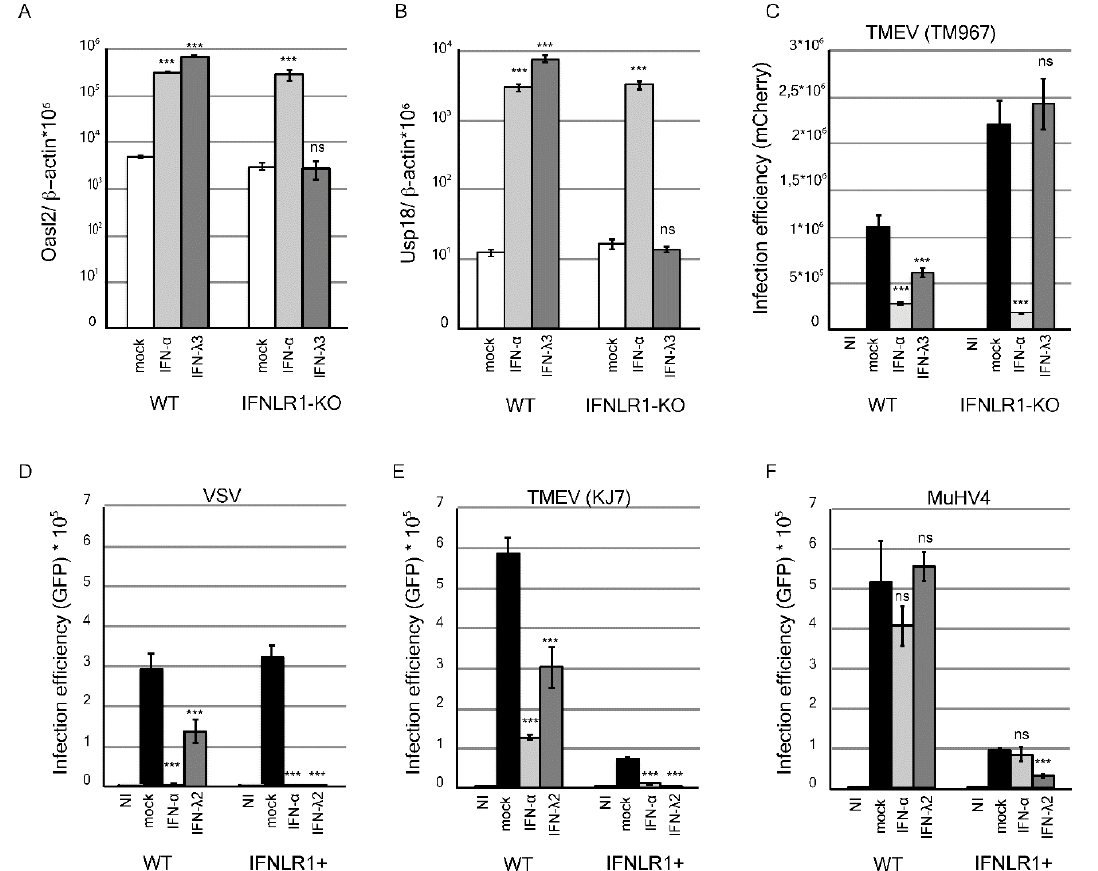
Figure 1. Interferon-stimulated gene (ISG) expression and antiviral activity in response to IFN- λ treatment in WT and IFNLR1-overexpressing LKR10 cells. ( A,B ) Amounts of Oasl2 ( A ) and Usp18 ( B ) per 10 6 β -actin cDNA copies detected in wild-type (WT) and IFNLR1-KO LKR10 cells 24 h after treatment with mouse IFN- α A, IFN- λ 3, or control medium (mock). ( C ) Infection efficiency in WT and IFNLR1-KO LKR10 cells measured by flow cytometry 24 h post-infection with 0.5 PFU/cell of TM967. Cells were pretreated with mouse IFN- α A, IFN- λ 3, or mock for 7 h prior to infection. ( D – F ) Infection efficiency in WT and IFNLR1-overexpressing (IFNLR1+) LKR10 cells measured by flow cytometry 8 h post-infection with 0.25 PFU/cell vesicular stomatitis virus (VSV)–GFP ( D ); or 24 h post-infection with 2.5 PFU/cell KJ7 ( E ) or 1 PFU/cell murid herpesvirus-4 (MuHV-4)–GFP ( F ). Cells